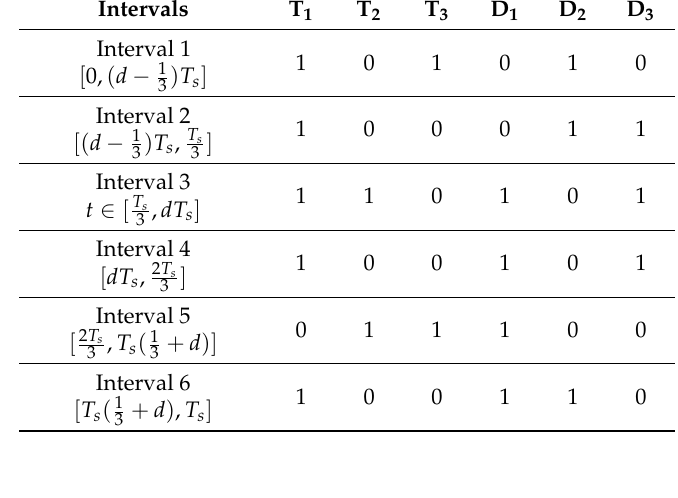
Table 2. Recap of the stats switches.